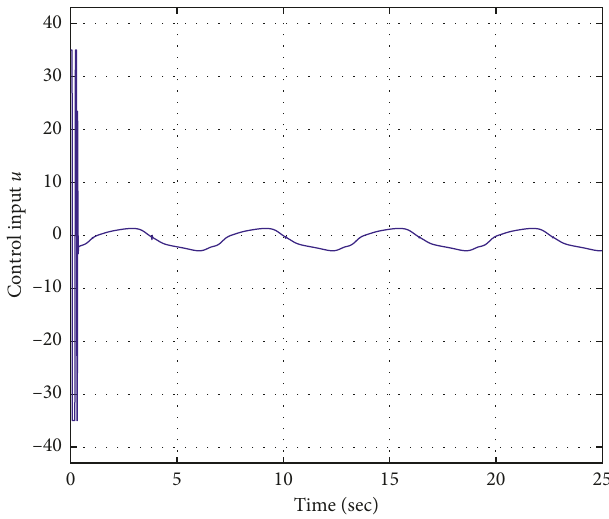
Figure 12: Evolution of the control